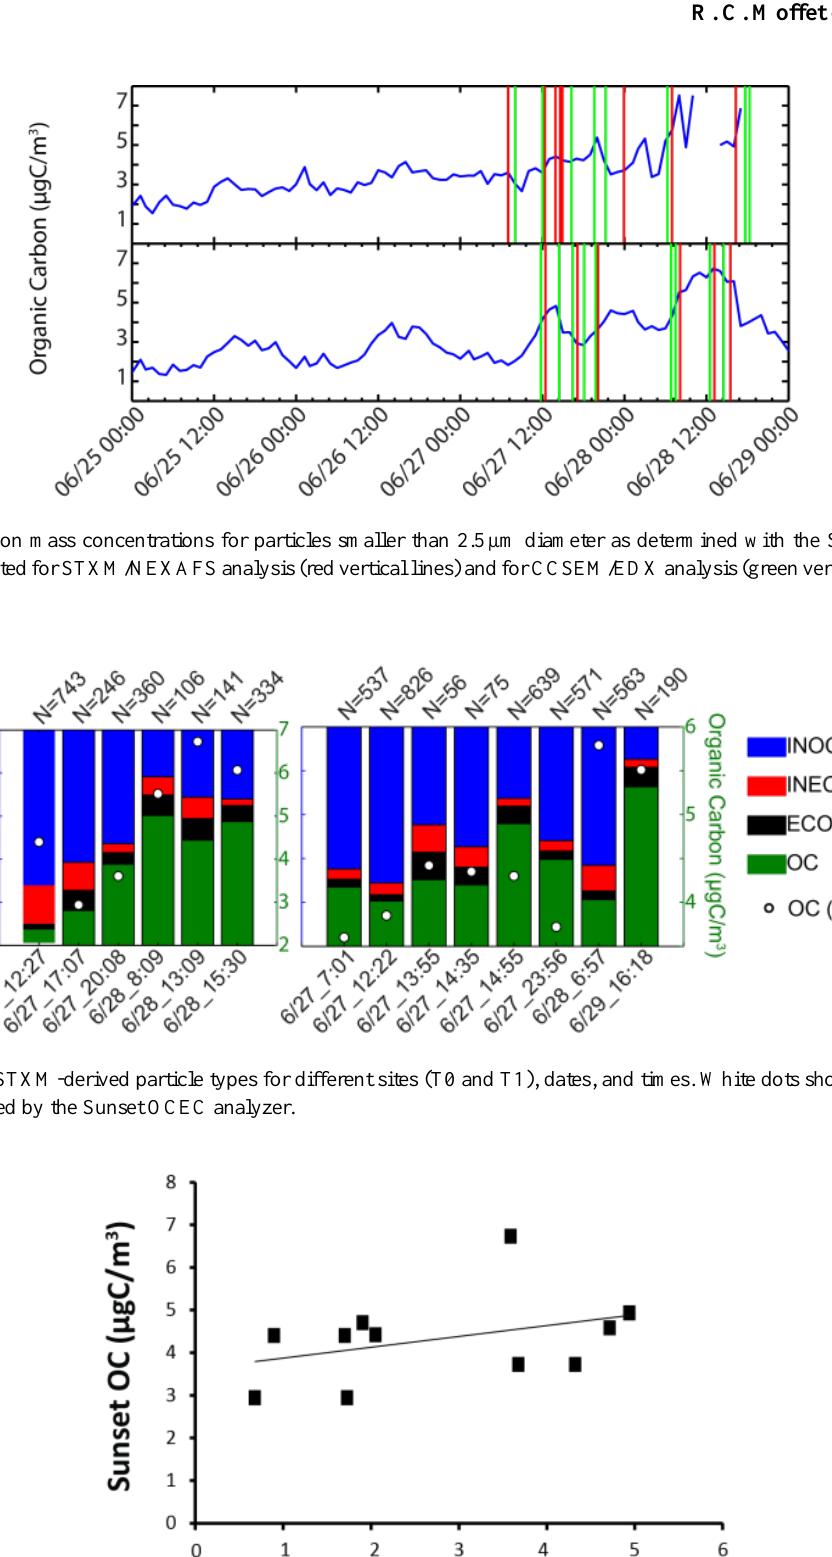
1 Figure 10. (B) Relationship between organic carbon optical density per particle and bulk organic 2 mass concentration measured by Sunset OCEC analyzer. 3